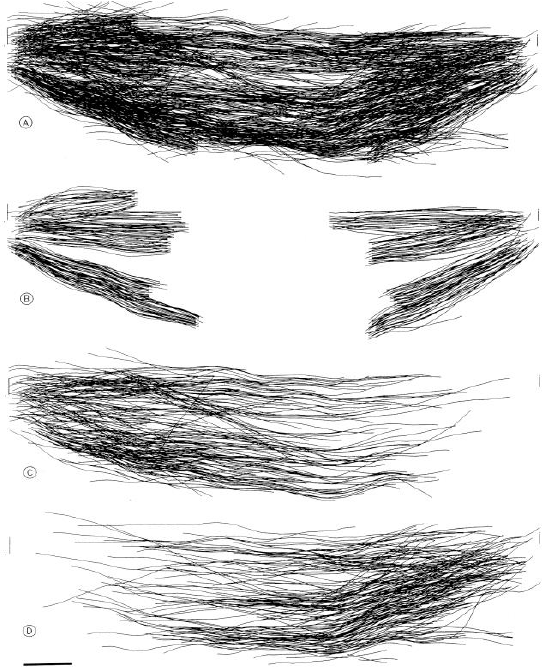
Figure 14. Two-dimensional projections of all the MTs in a volume that includes ~one-half of an early anaphase spindle from a PtK1 cell. ( A ) = all MTs traced; ( B ) = all kinetochore-associated MTs seen; ( C , D ) = all non-KMTs associated with the two spindle poles. From Mastronarde et al., 1993 [47]. This image is displayed under the terms of a Creative Commons License (Attribution-Noncommercial-Share Alike 3.0 Unported license, as described at http://creativecommons.org/licenses/by-nc-sa/3.0/.